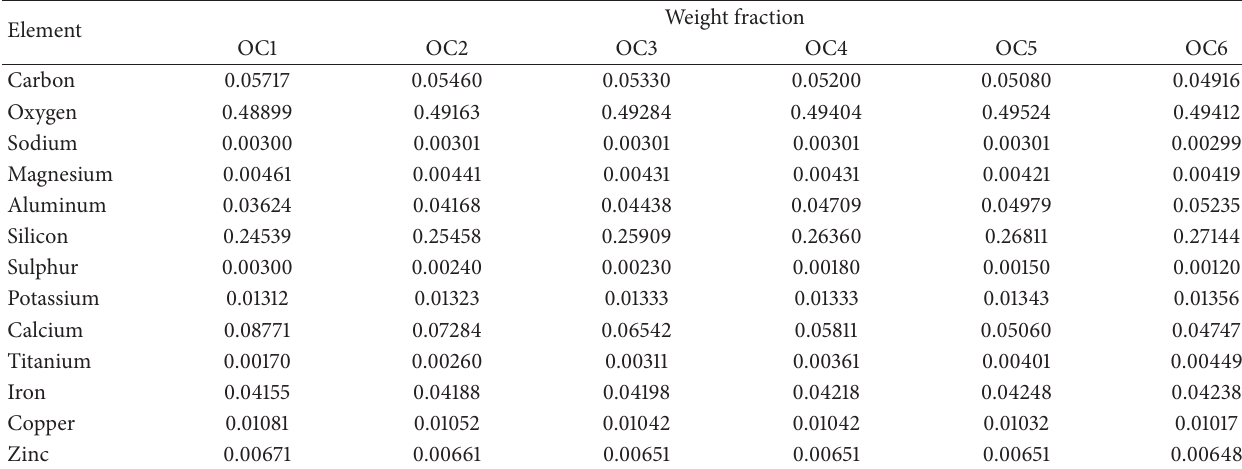
Figure 1: (a) Compressive strength of ordinary concrete versus age. (b) Compressive strength of flyash concrete versus age. Table 4: Elemental analysis of concrete